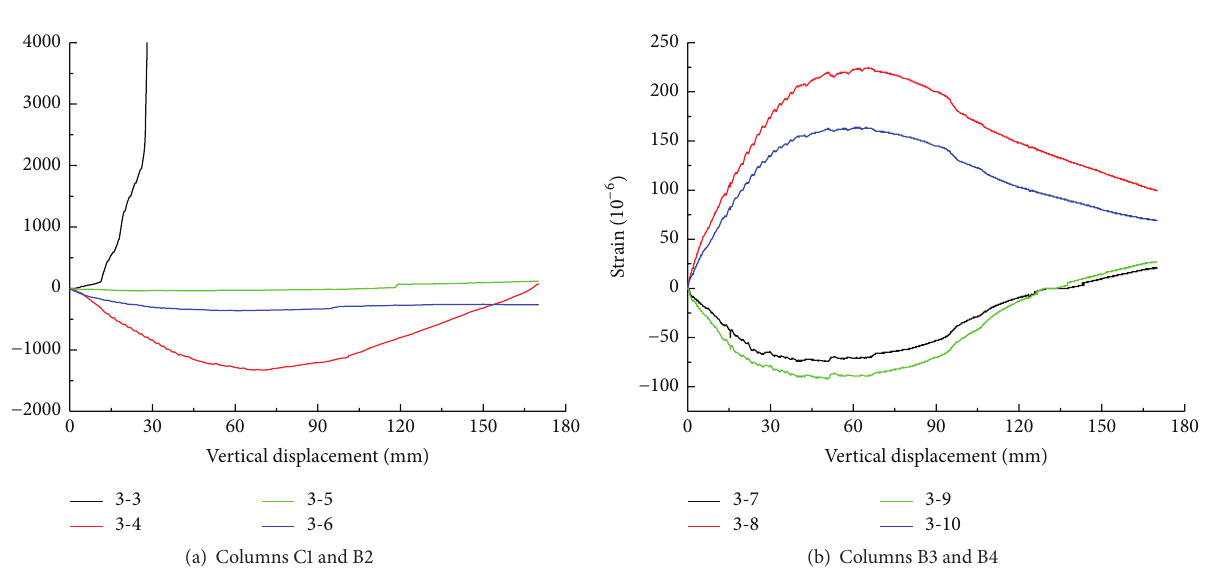
Figure 14: Strain response at the midspan of beam.